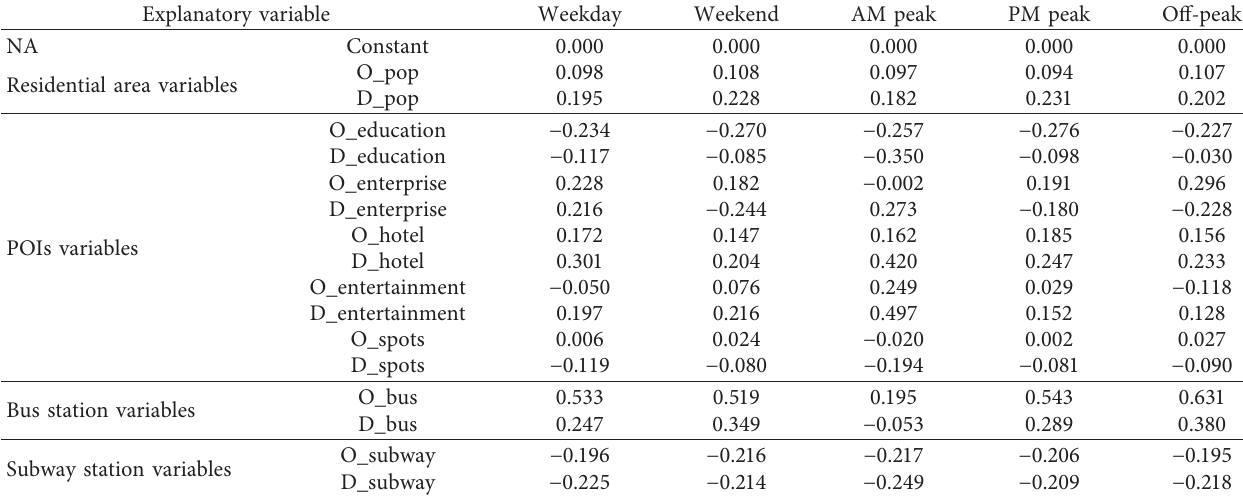
Table 6: Average coefficient of the GWR model during various